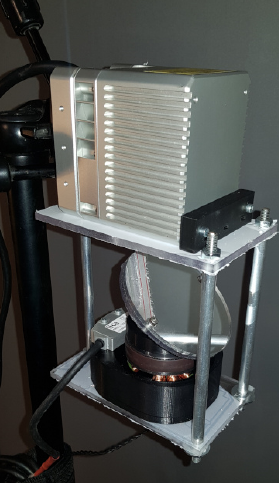
Figure 6. Photo of the mechanical design of the mirror